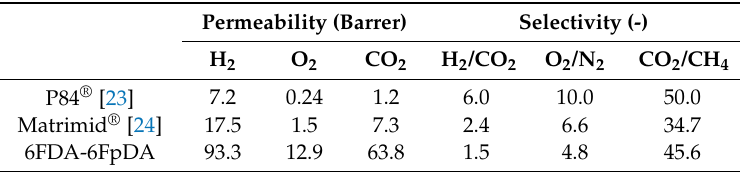
Table 1. Ideal permeability and selectivity for the polymers studied in this work as a thick film at room